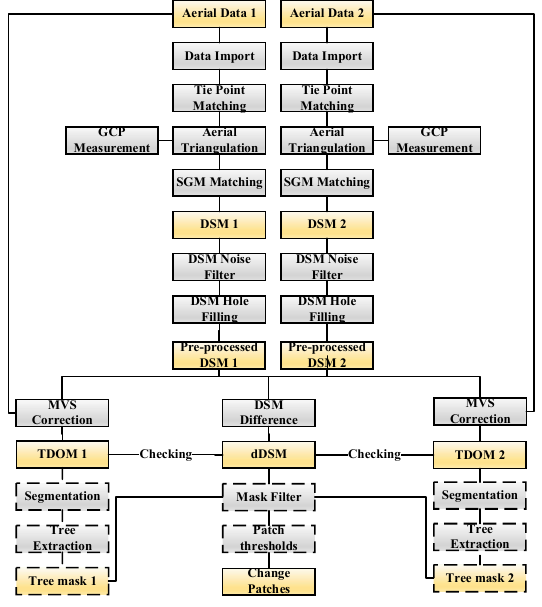
Figure 1. Urban construction land change detection work